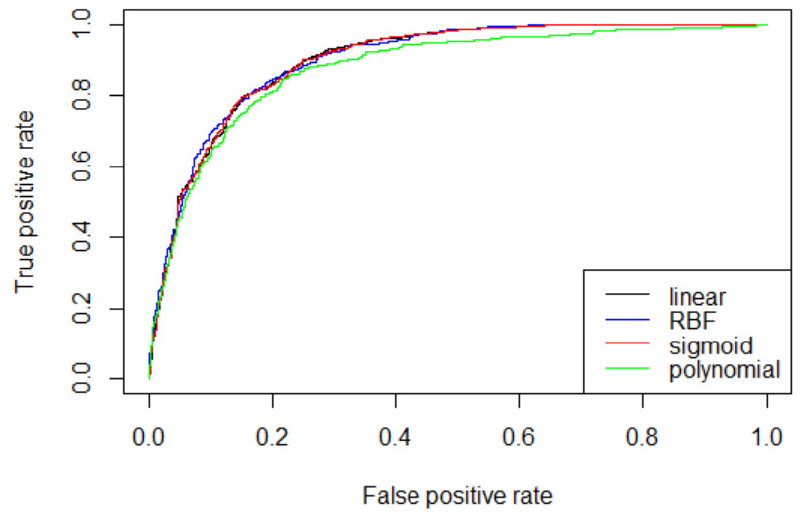
Figure 2. Comparison of ROC curve for four kernel functions.